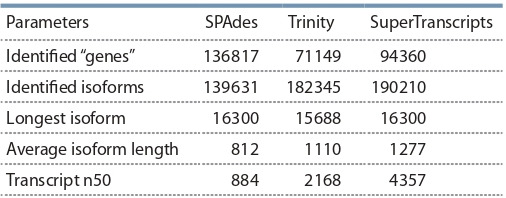
Comparison of transcriptome assemblies’ parametersNote: The estimated coverage for the transcriptome was 177x